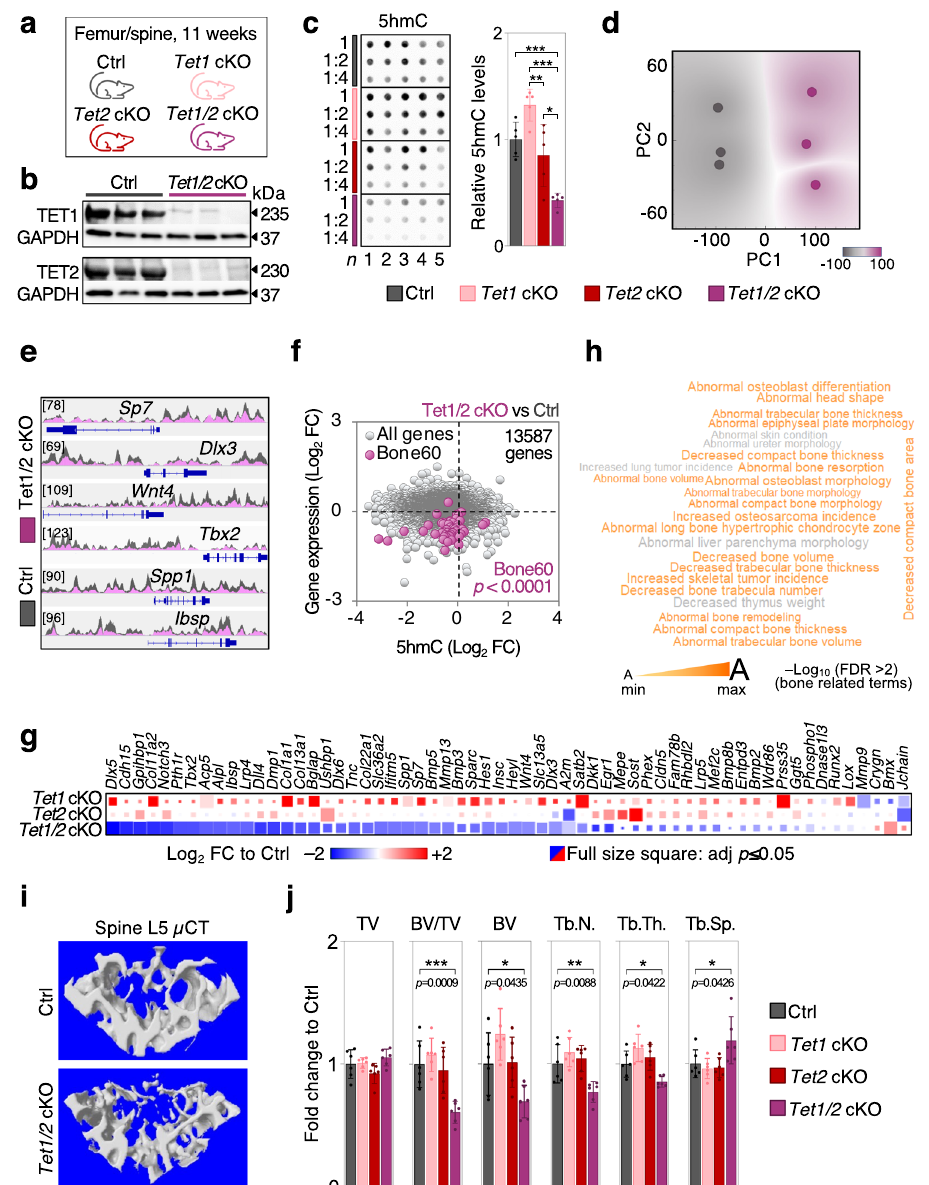
Fig. 10 | Conditional Tet1 and Tet2 deletion impairs DNA hydroxymethylation atbonerelatedloci and causesbonelossin mice. a Schematic representation of the mouse models used. Bone tissue was collected at 11 weeks; cKO, conditional knockout. b Prrx1 drivenTET1andTET2knockdownef fi